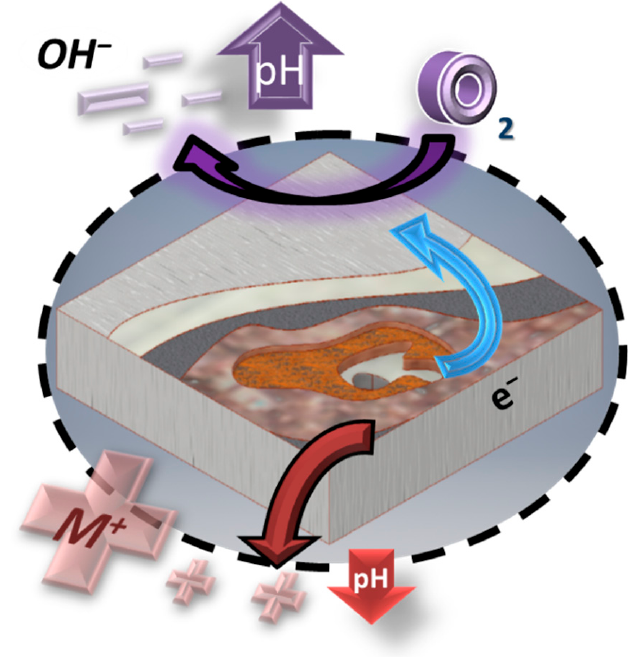
Figure 1. Sketch depicting the formation of localized microcells, the subsequent flow of ionic species in the electrolyte, and the pH changes associated with the onset of corrosion of a metal immersed in an alkaline or neutral aqueous medium.